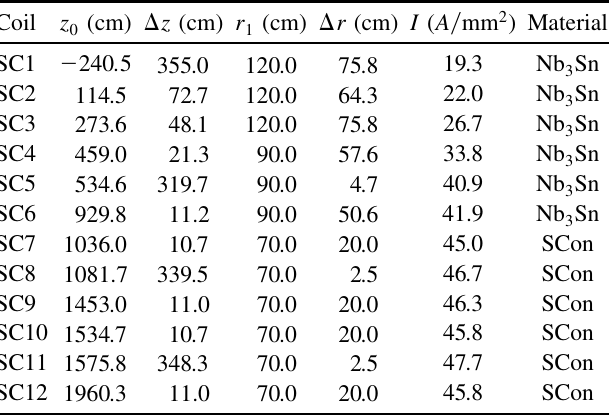
is the initial z 0 is the inner radius, 1 Sn and 3